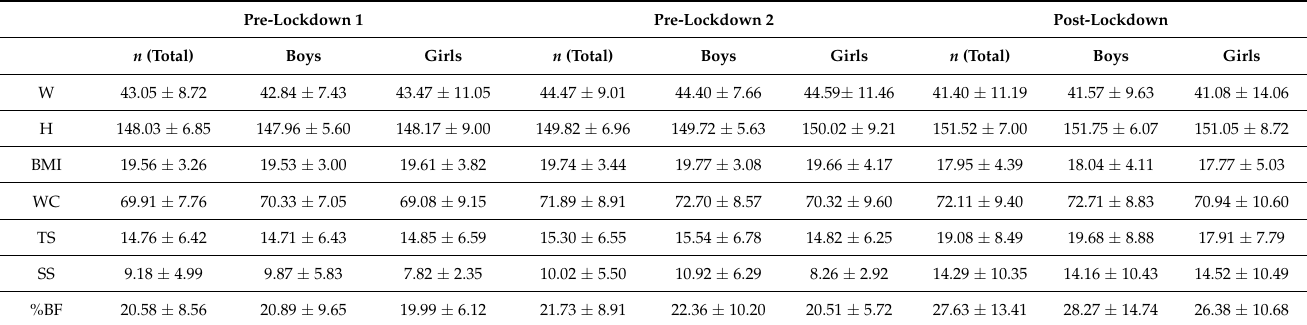
Table 2. Results of anthropometric variables as a function of data collection and gender.